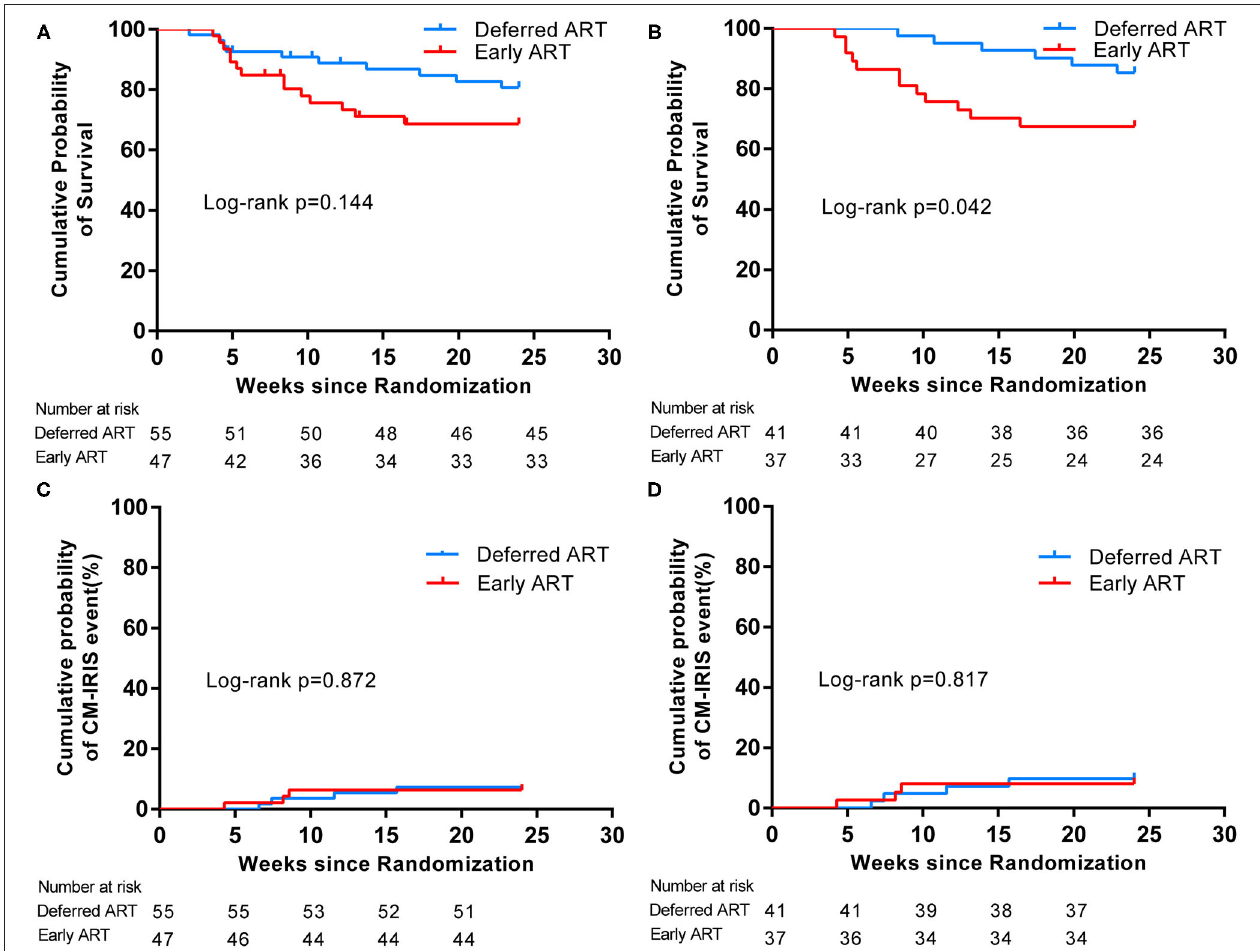
FIGURE 2 | Kaplan-Meier survival estimates of primary outcomes according to timing of ART. Cumulative probability of survival from randomization (time = 0) to 24 weeks in the Intention-to-Treat Population (A) and in the Per-Protocol Population (B) . Cumulative rates of CM-IRIS events in the Intention-to-Treat Population (C) and in the Per-Protocol Population (D)